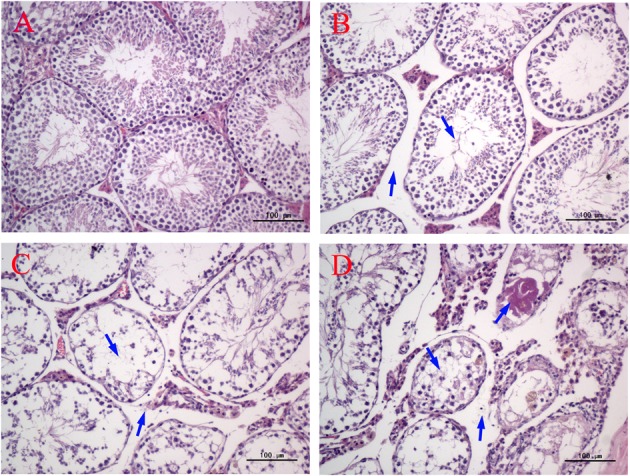
Effect of MEQ on the microphotographs of testes (200×). (A) Testes from the control group. Arrows show the testicular interstitial and seminiferous tubules are normal. (B) Testes from the 25 mg/kg MEQ group. Arrows show broadened interstitial testicular tissue, a few vacuoles in seminiferous tubules. (C) Testes from the 55 mg/kg MEQ group. Arrows show necrosis of the spermatogonia and spermatocytes in the lumen and the broadened interstitial testicular tissue. (D) Testes from the 110 mg/kg MEQ group. Arrows show seminiferous tubules with marked atrophy and red stained filamentous proteins (n = 5).